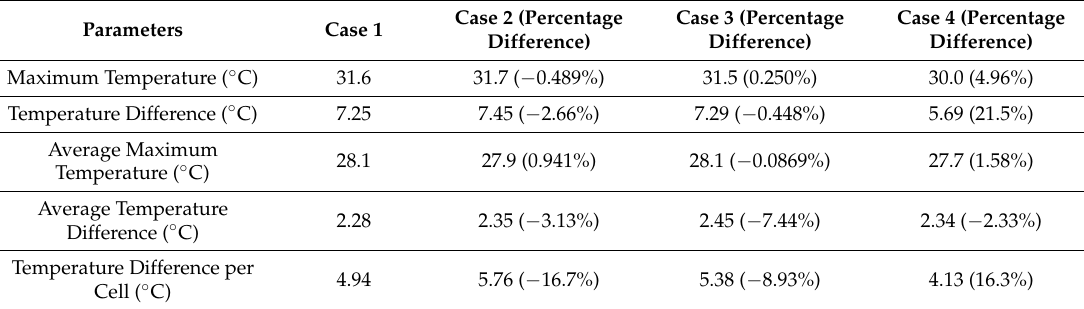
Table 6. Comparison of Cases 2, 3, and 4 with Case 1 (the baseline